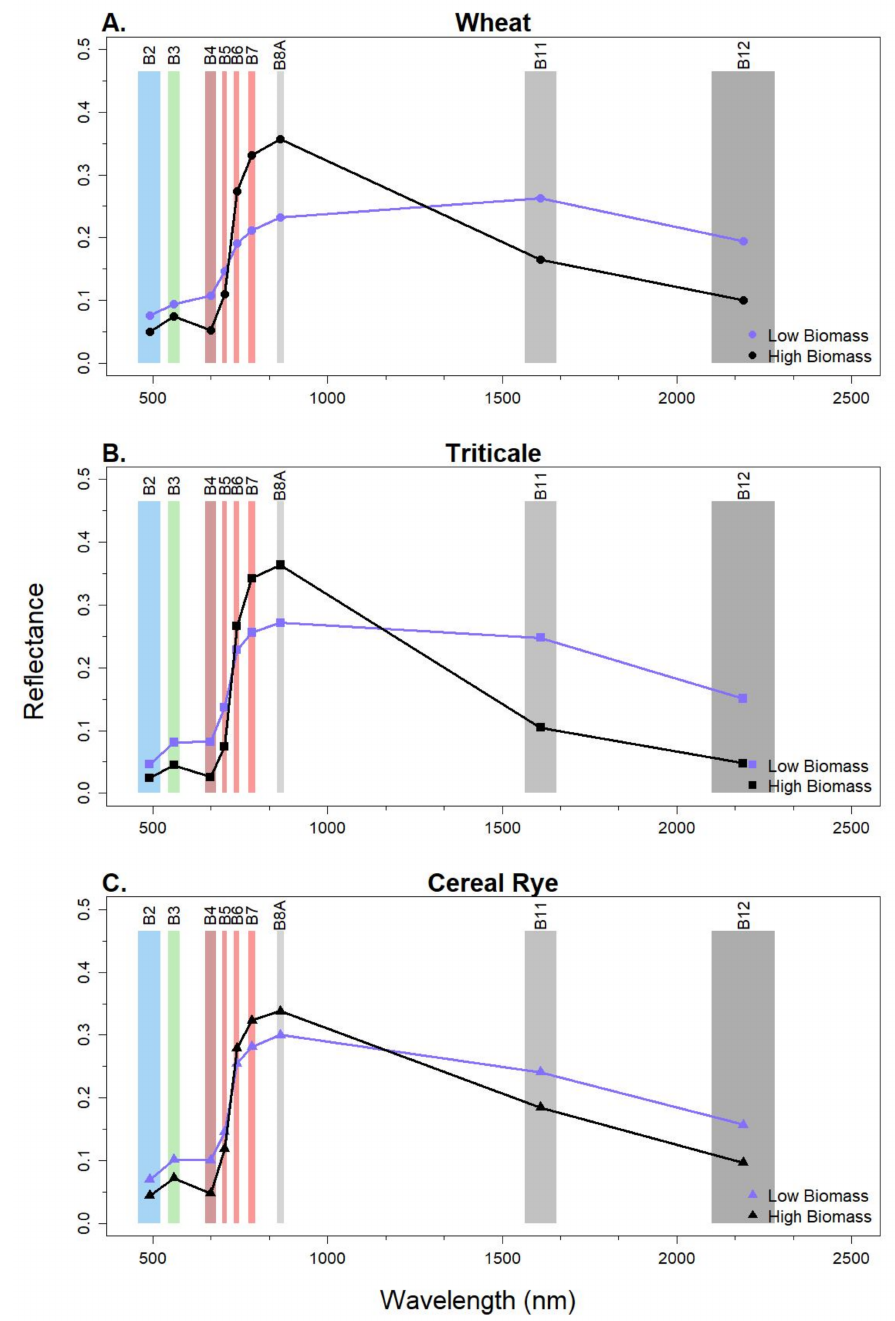
Figure 4. Example of spectral reflectance of high (~3500 kg ha − 1 ) and low (<1000 kg ha − 1 ) biomass for ( A ) wheat, ( B ) triticale, and ( C ) cereal rye. Sentinel-2 bands are labeled in each